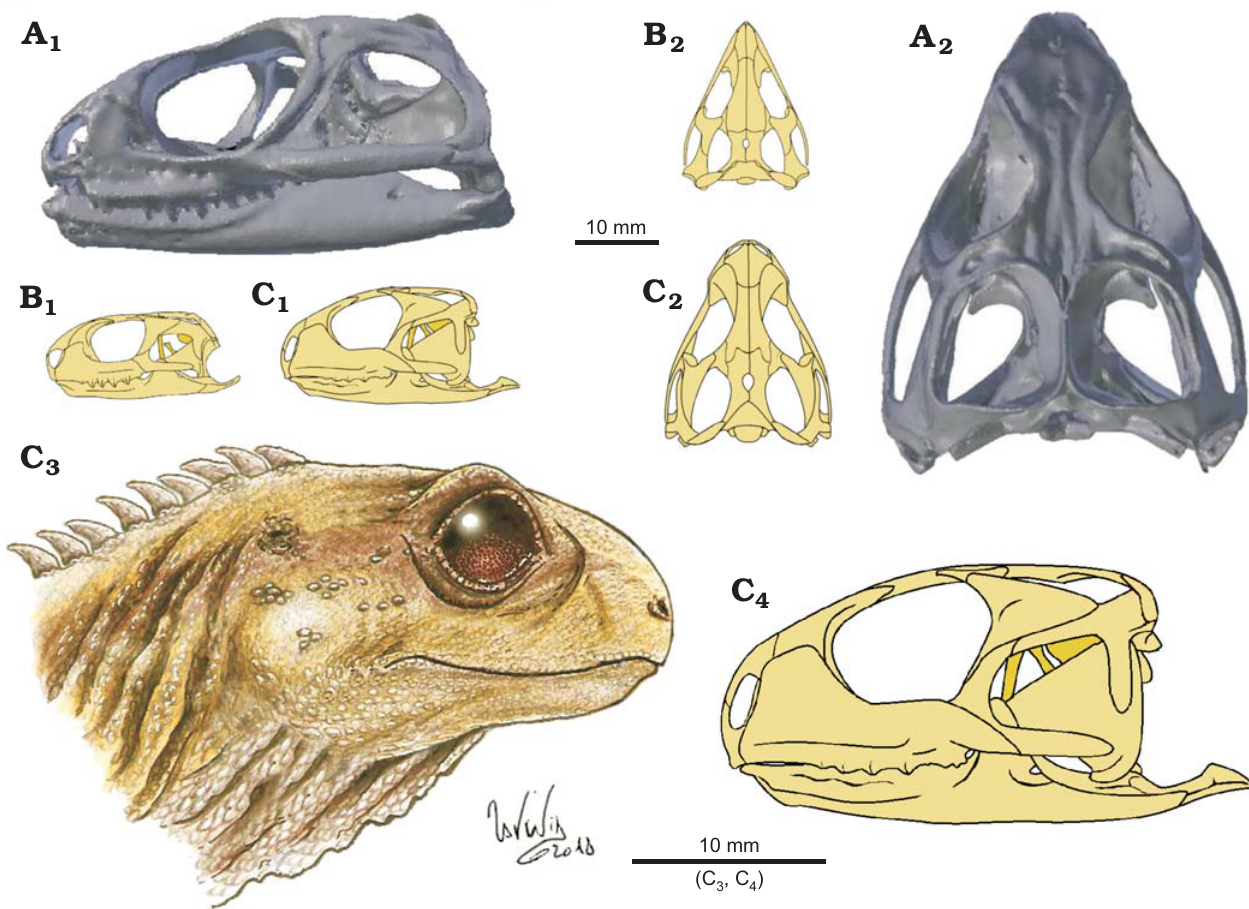
Fig. 15. A size scale comparison of the skulls of lepidosaur rynchocephalians. A . Sphenodon punctatus (from Maisano 2001). B . Clevosaurus cambrica Keeble, Whiteside, and Benton, 2018. C . Clevosaurus hudsoni Swinton, 1939; C 3 , based on NHMUK PV R36832 (adapted from illustrations by Lavinia Gandolfi). In lateral (A 1 –C 1 , C 4 ) and dorsal (A 2 –C 2 )